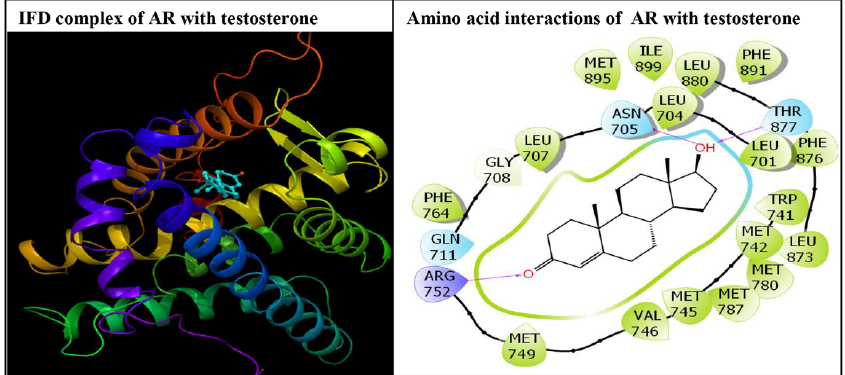
Figure 3. The docking display of the androgen receptor (AR) in complex with the native ligand, testosterone (left panel), and the molecular interactions of testosterone with residues lining the AR ligand binding pocket (right panel). The cyan colored amino acids lining the ligand binding pocket represent polar residues. The green colored amino acid residues represent hydrophobic residues, and the purple colored amino acid represents positively charged residues. The red colored arrows indicate hydrogen bonding interactions between the ligand and receptor amino acid residues. Two cis-stereoisomers, permethrin (1 S 3 S )- cis (Figure 2a) and permethrin (1 R 3 R )- cis (Figure 2c), interacted with 23 and 24 amino acid residues, respectively, in the AR ligand binding pocket. Overall, 100% commonality in interacting AR amino acid residues was observed between the native ligand, testosterone, and both of the aforementioned cis -en- antiomers. Both cis-enantiomers displayed one pi–pi interaction with the amino acid res- idue Phe-764. In addition, the permethrin (1 R 3 R )- cis enantiomer also displayed one hy- drogen binding interaction with the Thr-877 residue. The remaining two stereoisomers, permethrin (1 R 3 S )- trans (Figure 2b) and permethrin (1 S 3 R )- trans (Figure 2d) ( trans -enan- tiomers), displayed interactions with 22 and 21 amino acid residues of the AR, respec- tively. However, approximately 86% commonality was observed in the interacting resi- dues of the native ligand, testosterone, and each trans-enantiomer. Further, permethrin (1 R 3 S )- trans displayed one pi–pi interaction with Phe-876, and permethrin (1 S 3 R )- trans displayed hydrogen bonding interaction with Thr-877. IFD-associated parameters such as IFD score, Glide score, dock score, and binding energy values for all four stereoisomers of permethrin as well as for the AR native ligand, testosterone, are presented (Table 1). The IFD scores, Glide scores, and dock scores of all the stereoisomers were similar to the values calculated for the native ligand, testosterone. Furthermore, the binding energy values of all ligands except permethrin (1 S 3 S )- cis were comparable to the native ligand. The binding energy values calculated for permethrin (1 S 3 S )- cis were lower than the values calculated for the other three stereoisomers.